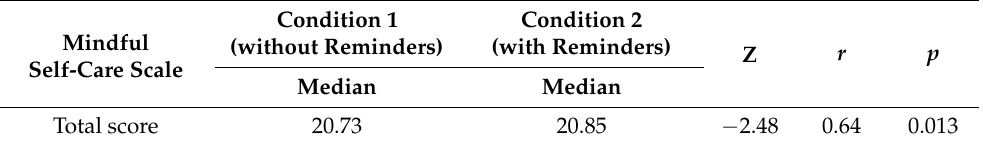
Table 2. Differences between Mindful self-care scale total score without reminders and with reminders. Mindful Self-Care